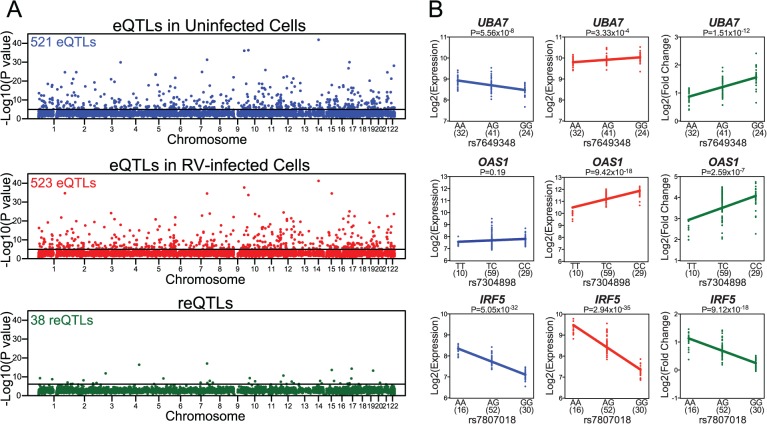
Identification of local eQTLs and reQTLs.
(A) Manhattan plots of local eQTLs in uninfected cells (in blue), local eQTLs in RV-infected cells (in red), and local reQTLs (in green). Most significant local eQTL or local reQTL P value for each gene (y-axis) is displayed in the order of chromosomal positions of the genes detected as expressed in our study (x-axis). (B) Examples of genes with reQTLs. In each plot, genotype at the reQTL is shown on the x-axis and expression level (Log2 Expression) or response in gene expression (Log2 Fold Change) is shown on the y-axis. Sample sizes for each genotype group are shown in parentheses under the x-axis.